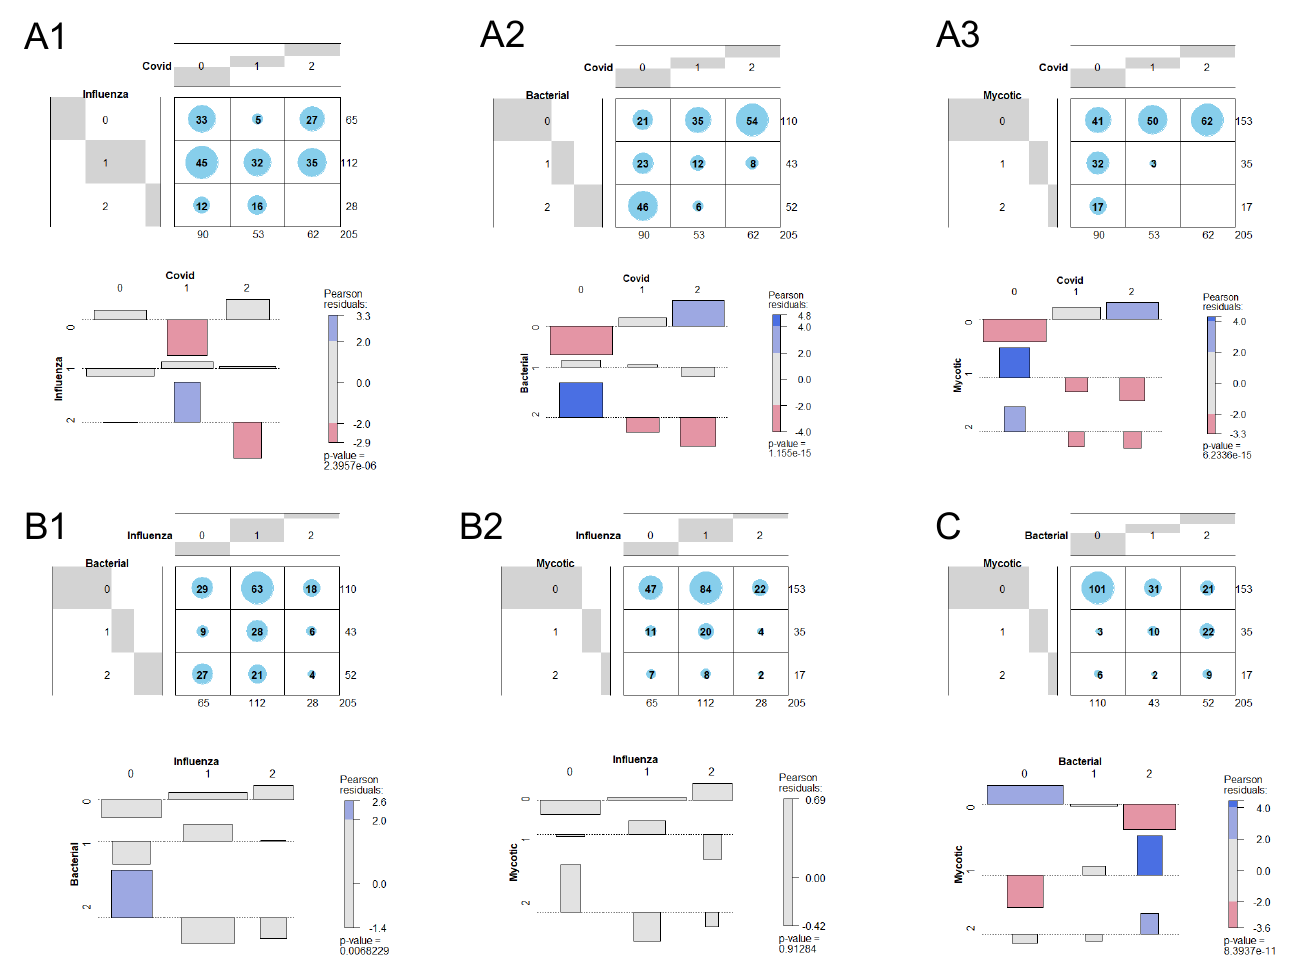
Figure 3. Dependencies of radiologists’ suspicion scores for different pathogen categories were screened by Pearson’s Chi 2 Test for Independence (graphic illustration). Distribution of reading scores for every combination of pathogen category (influenza, COVID-19, bacterial, mycotic) are illustrated by 3 × 3 contingency tables. Cohen-Friendly Association Plots illustrate deviations from the statistically expected contingency table in the case of total independency. In the Cohen-Friendly Association Plot, each cell of the contingency table is represented by a rectangle that has a (signed) height proportional to its contribution to the Chi 2 Statistic. Simultaneously, the area of the box is proportional to the difference in observed and expected frequencies. The rectangles in each row are positioned relative to a baseline indicating independence/no contribution to the Chi 2 Statistic. If the observed frequency of a cell is greater than the expected one, the box rises above the baseline and is shaded in blue. Otherwise, the box falls below the baseline and is shaded in red. Discrepancies from the independency scenario are quantified by Pearson Residuals (PR), which can be interpreted as follows: − 2 < PR < 2—no significant dependency/ − 4 < PR < − 2 or 2 < PR < 4—significant dependency/PR < − 4 or PR > 4—strong significant dependency. The displayed p -values are the noncorrected. Corresponding statistical analysis corrected for multiple testing by the Bonferroni method is illustrated in Table 3. Under-represented co-occurrent suspicions for mycotic/COVID- 19 pneumonia or bacterial/COVID-19 pneumonia indicate specific image features of COVID-19 pneumonia ( A2 / A3 ). Contrarily, over-represented co-suspicions for bacterial/mycotic pneumonia indicate partially shared image features ( C